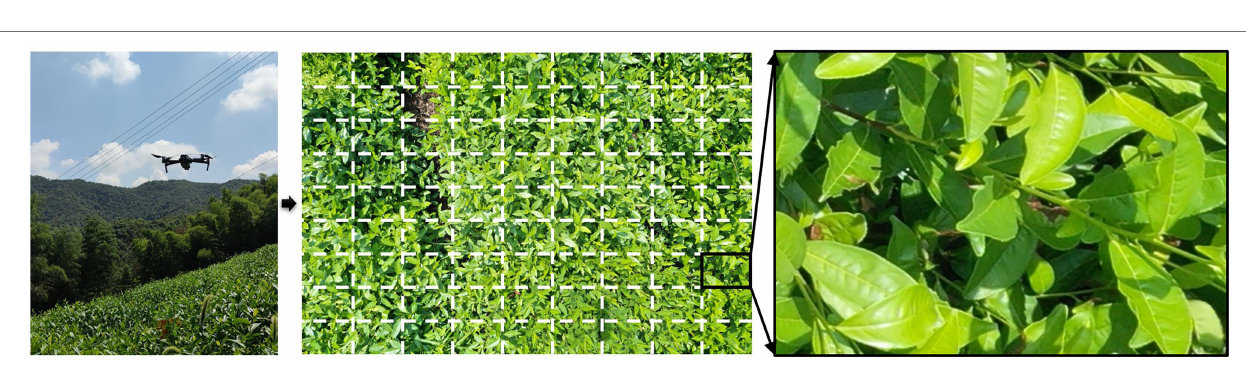
FIGURE 12 | The demonstration of unmanned aerial vehicle (UAV) image and image fragmentation of tea plant